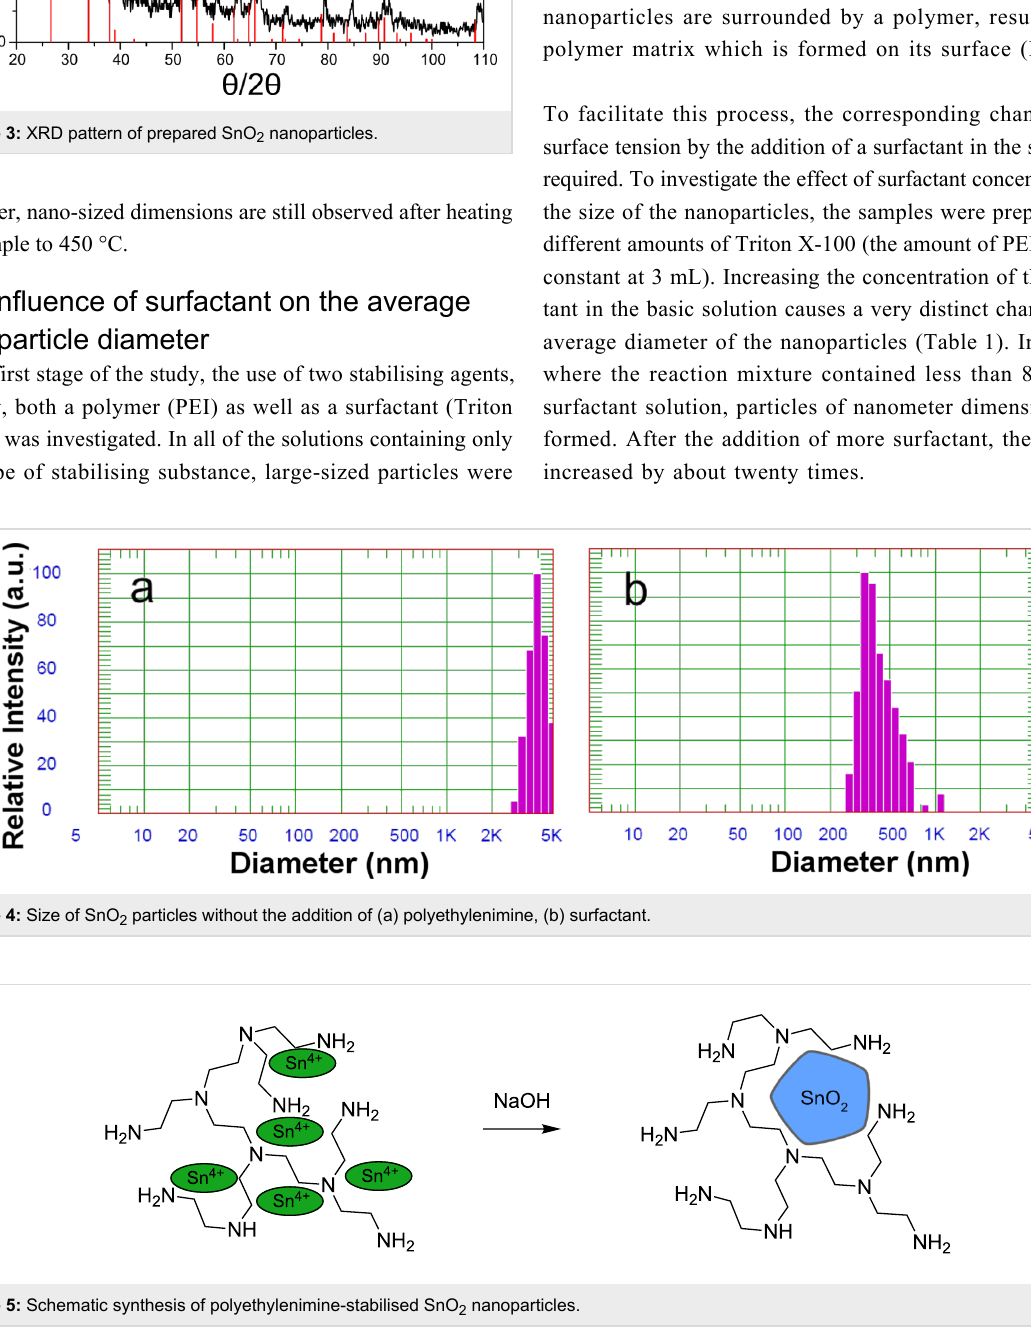
Figure 3: XRD pattern of prepared SnO 2 nanoparticles.